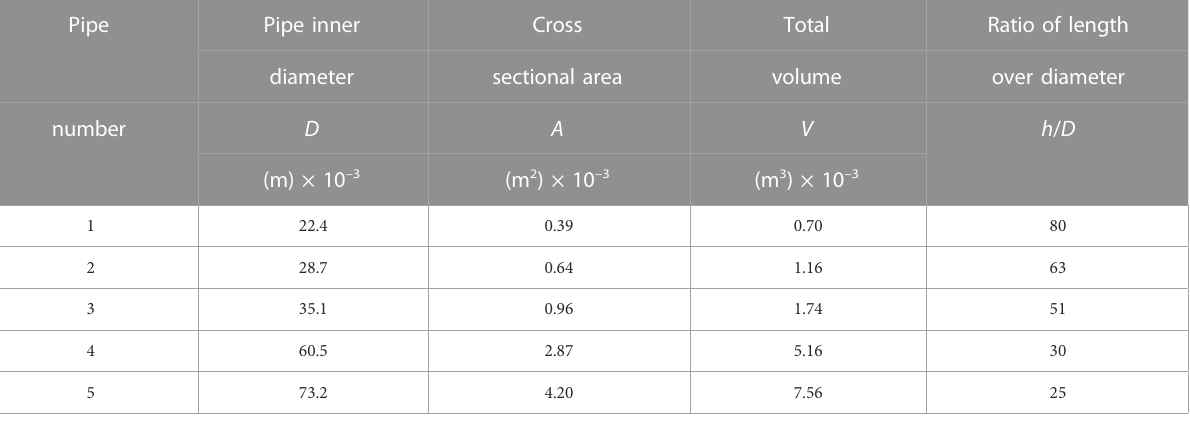
of a vertical pipe. Figure 1 shows a schematic drawing of the experimental setup.